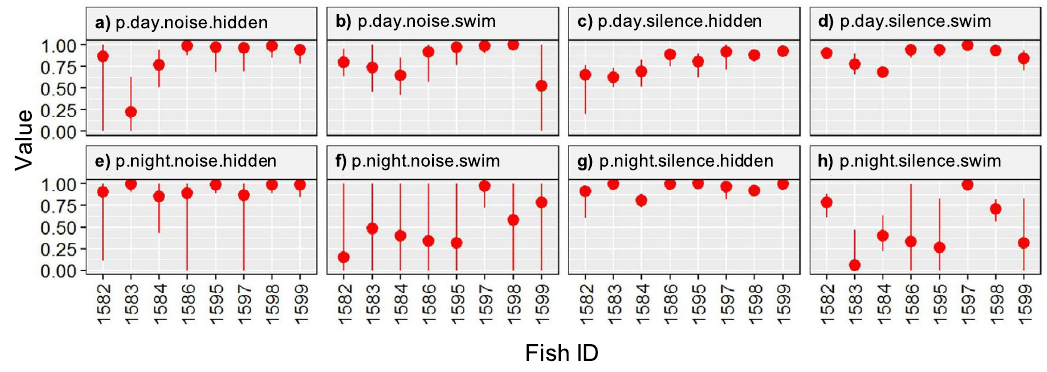
Figure 7. Means and Bayesian Credibility Interval (BCI) for behavioural values estimated by the Space State Model. p represents the probability of remaining in the same state (hidden or swimming). ( a ) p during the day in presence of noise peaks generated by passing motorboats when the fish is hidden. ( b ) p during the day in presence of noise peaks generated by passing motorboats when the fish is swimming. ( c ) p during the day in absence of noise peaks generated by passing motorboats when the fish is hidden. ( d ) p during the day in absence of noise peaks generated by passing motorboats when the fish is swimming. ( e ) p at night in presence of noise peaks generated by passing motorboats when a fish is hidden. ( f ) p at night in presence of noise peaks generated by passing motorboats when a fish is swimming. ( g ) p at night in absence of noise peaks generated